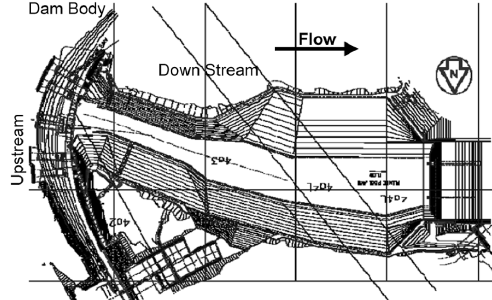
Fig. 2. Plan view of Karun III